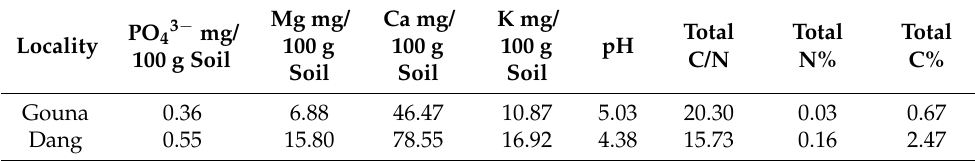
Table 1. Soil chemical